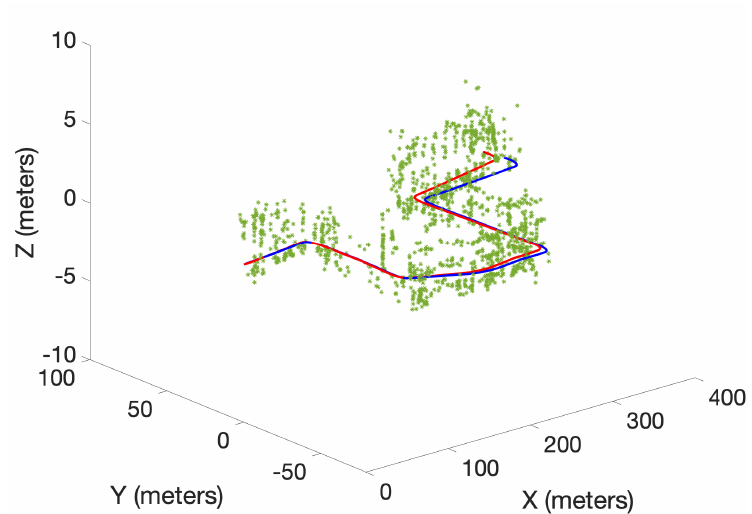
Figure 9. The estimated map (green) and the trajectory (red) using δ -GLMB-SLAM2.0 with ground truth trajectory (blue).